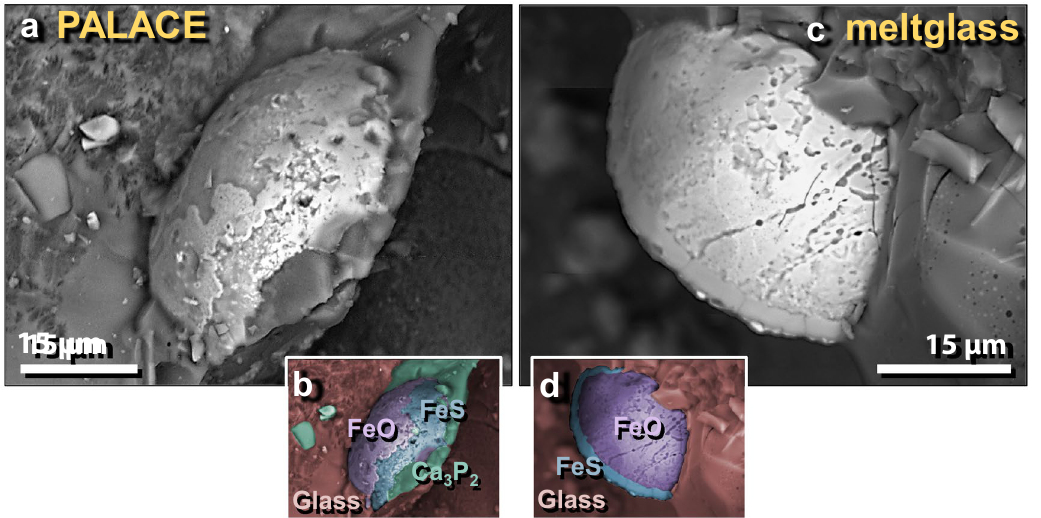
Figure 41. SEM images of Fe–S–Ca–P-rich grains in mudbrick meltglass from the palace. ( a ) Melted Fe-rich grain is chemically complex, containing Fe, S, Ca, and P. ( b ) Manually constructed EDS-based phase map marking areas of Fe oxides (purple, labeled as FeO), FeS (blue), and Ca 3 P 2 , calcium phosphide (green). ( c ) High- temperature melted Fe-rich grain; ( d ) manually constructed EDS-based phase map showing the area that is predominantly Fe oxide, bordered by a thin rim of